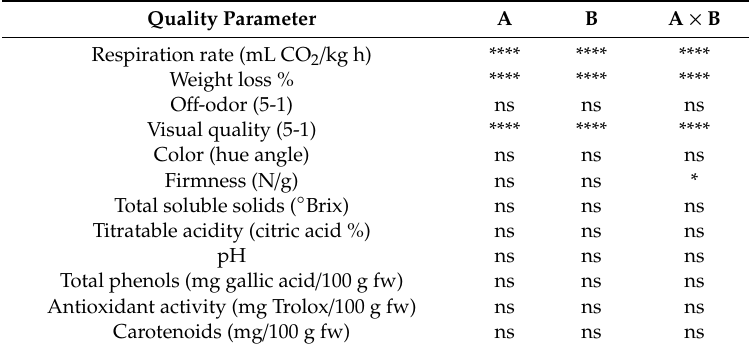
Table 2. E ff ect of treatment (Active-pMA and Control) (A), storage time (3, 7, and 13 days at 8 ◦ C) (B) and their interaction (A × B) on quality parameters evaluated in blueberries (cv Rebel).